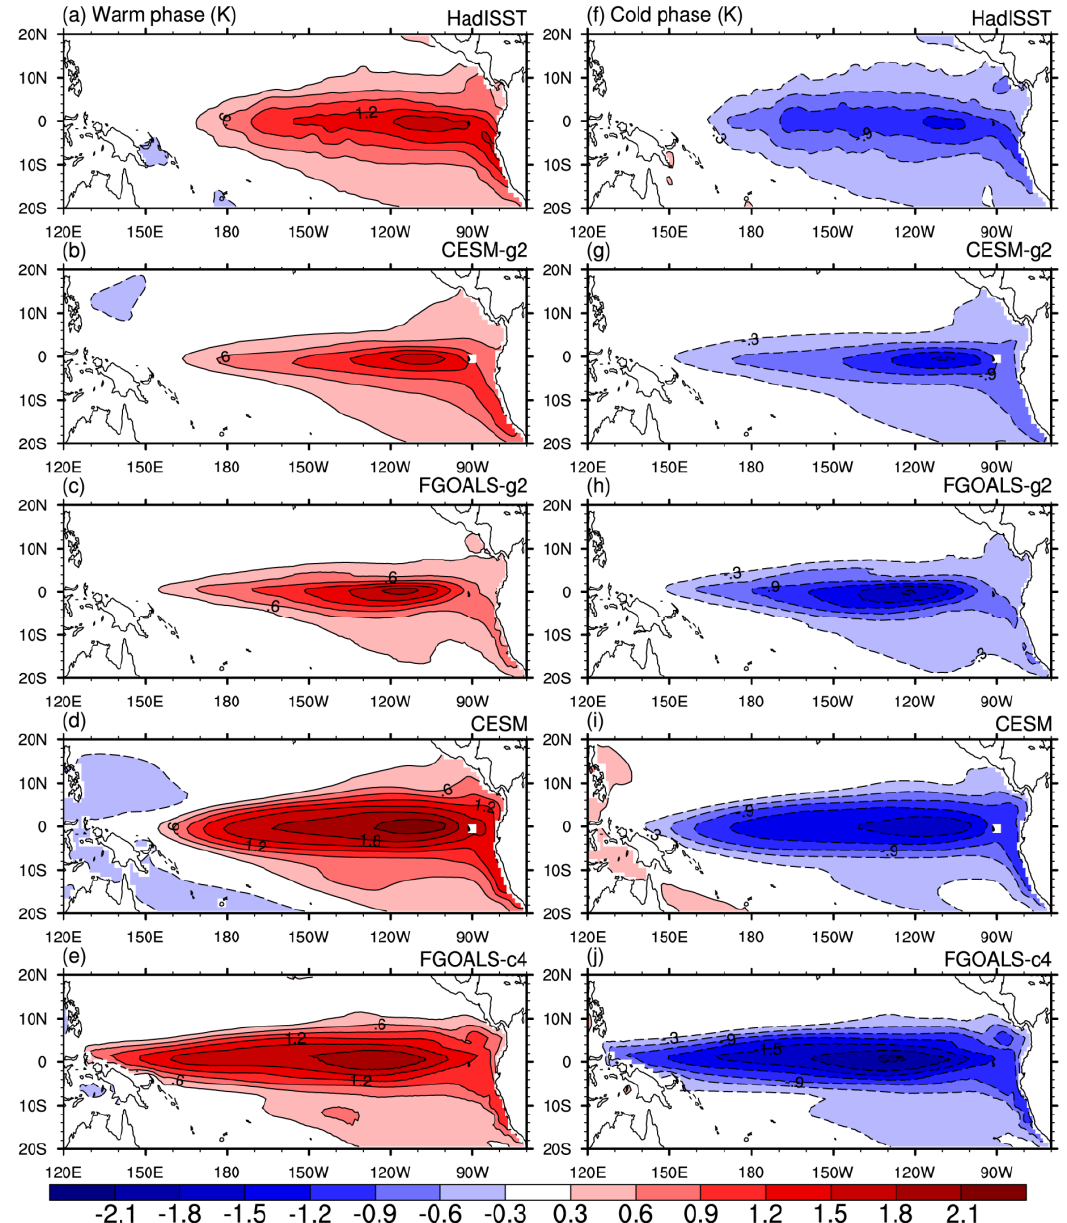
Figure 2. Spatial pattern of averaged composite SST anomalies for El Niño (Left) and La Niña (right) events from the ( a , f ) observations and the four cross-coupled parent models: ( b , g ) CESM-g2, ( c , h ) FGOALS-g2, ( d , i ) CESM, ( e , j ) FGOALS-c4. The criterion for an El Niño (La Niña) event is that SST anomalies averaged in the Niño-3 area are greater (less) than 0.5 K ( − 0.5 K) for five consecutive months. The period used for the composites was 100 years, i.e., 1900–1999 for the observations and 401–500 for the parent models.